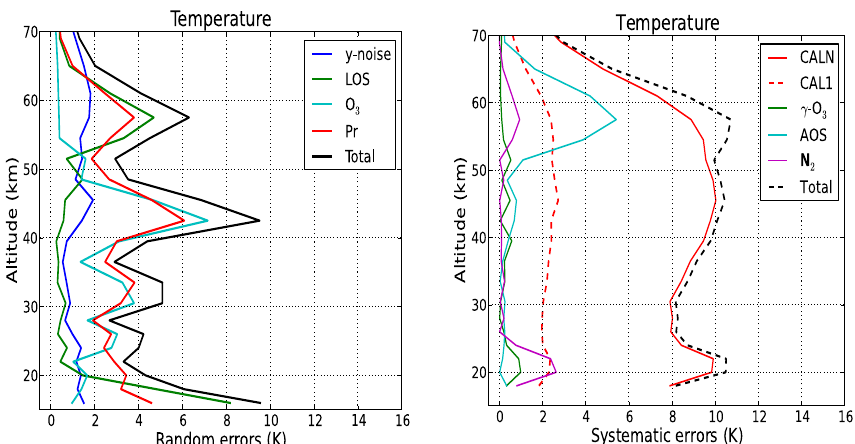
Fig. 12. Random (left panel) and systematic (right panel) errors on the temperature profile retrieved from window A/B w1. Random errors are from the measurement noise (blue line), O 3 (cyan line), line-of-sight angle (green), the pressure profile (red line). The black line is the total error calculated as the root-sum-square of all sources of error. The meaning of the labels of the systematic errors and the assumed errors on the parameters are given in Table